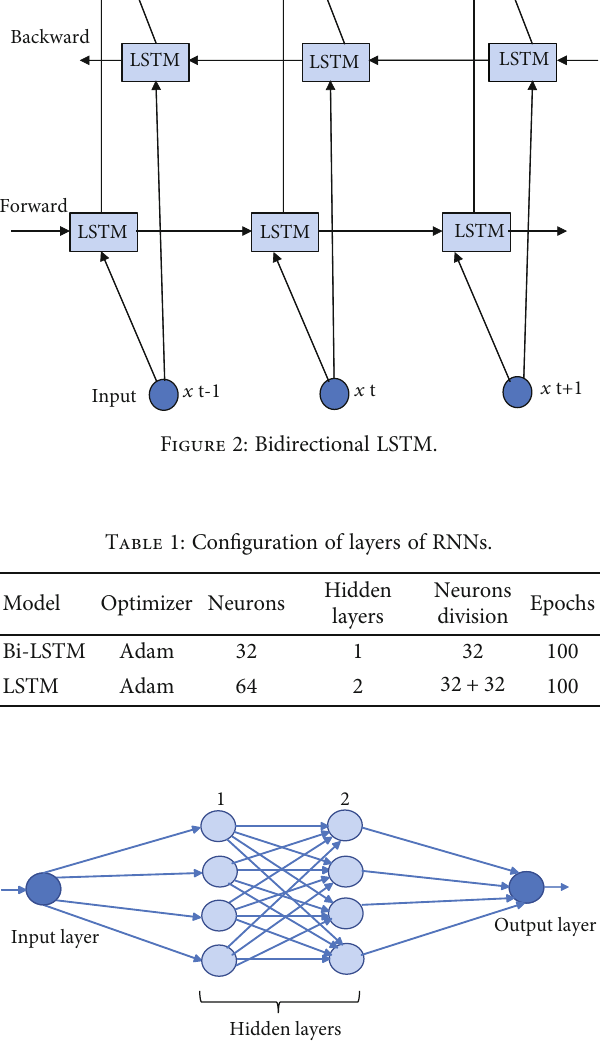
Figure 3: Block diagram of layers con fi guration of